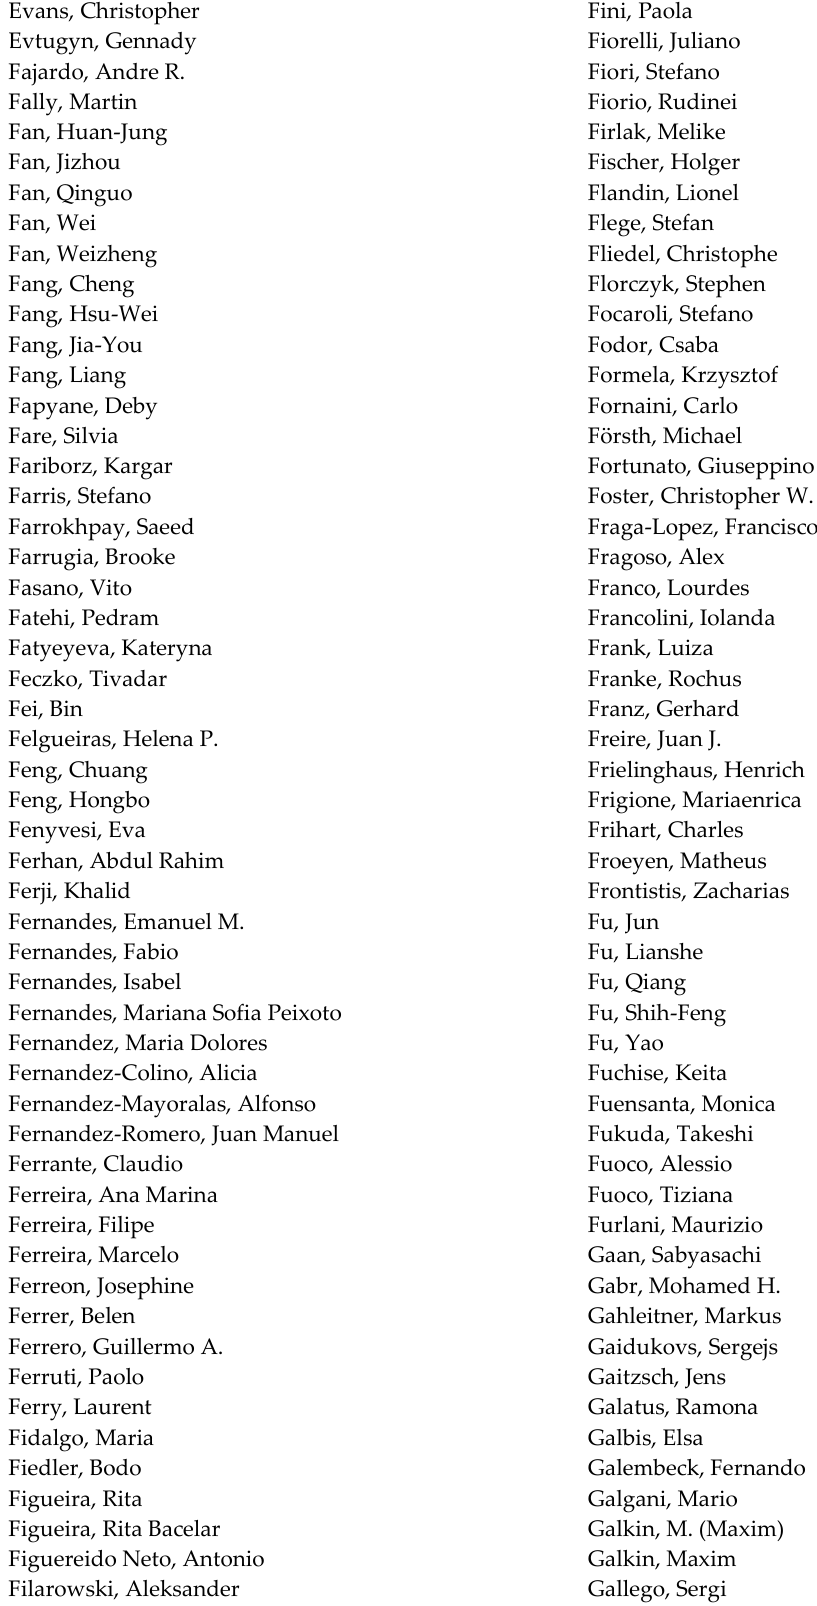
Figueira, Rita Figueira, Rita Bacelar Figuereido Neto,